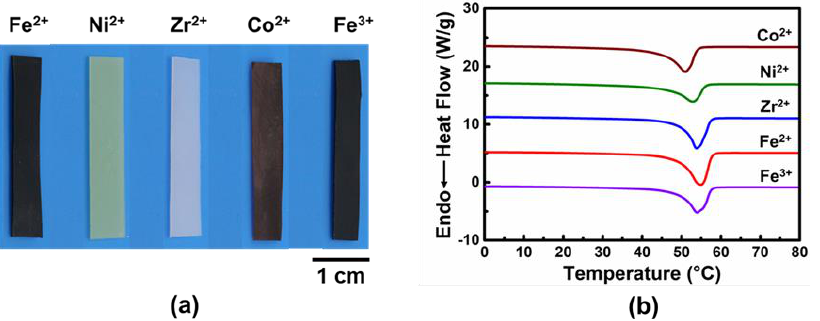
Figure 2. Features of acquired SMPs. ( a ) Appearance of the films doped with different metal ions. ( b ) The differential scanning calorimetry curves.